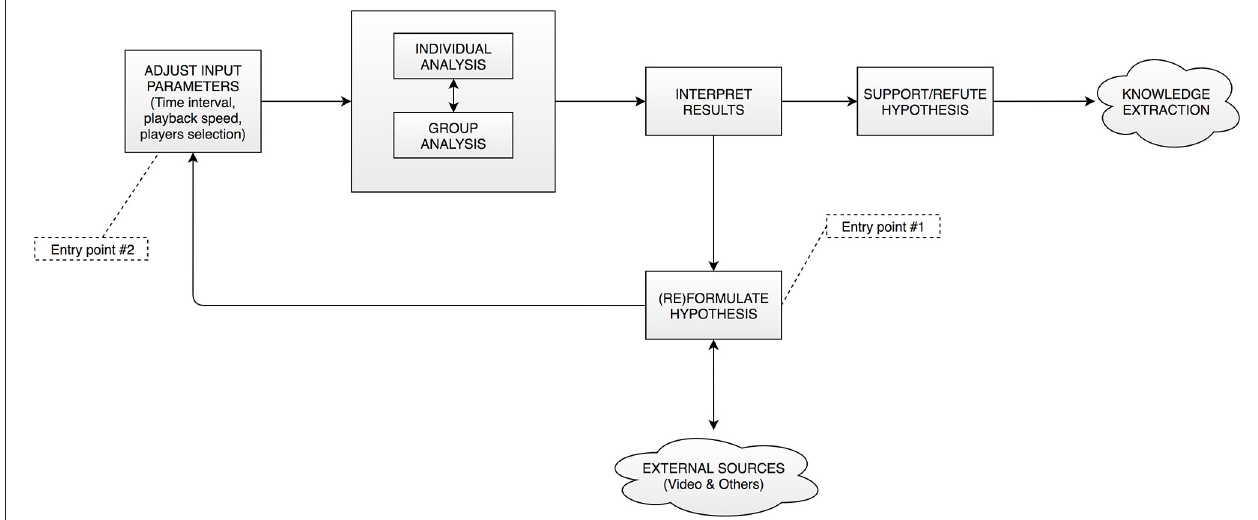
FIGURE 1 | Proposed workflow. The user starts the analysis tasks at either of the two entry points to the tool.